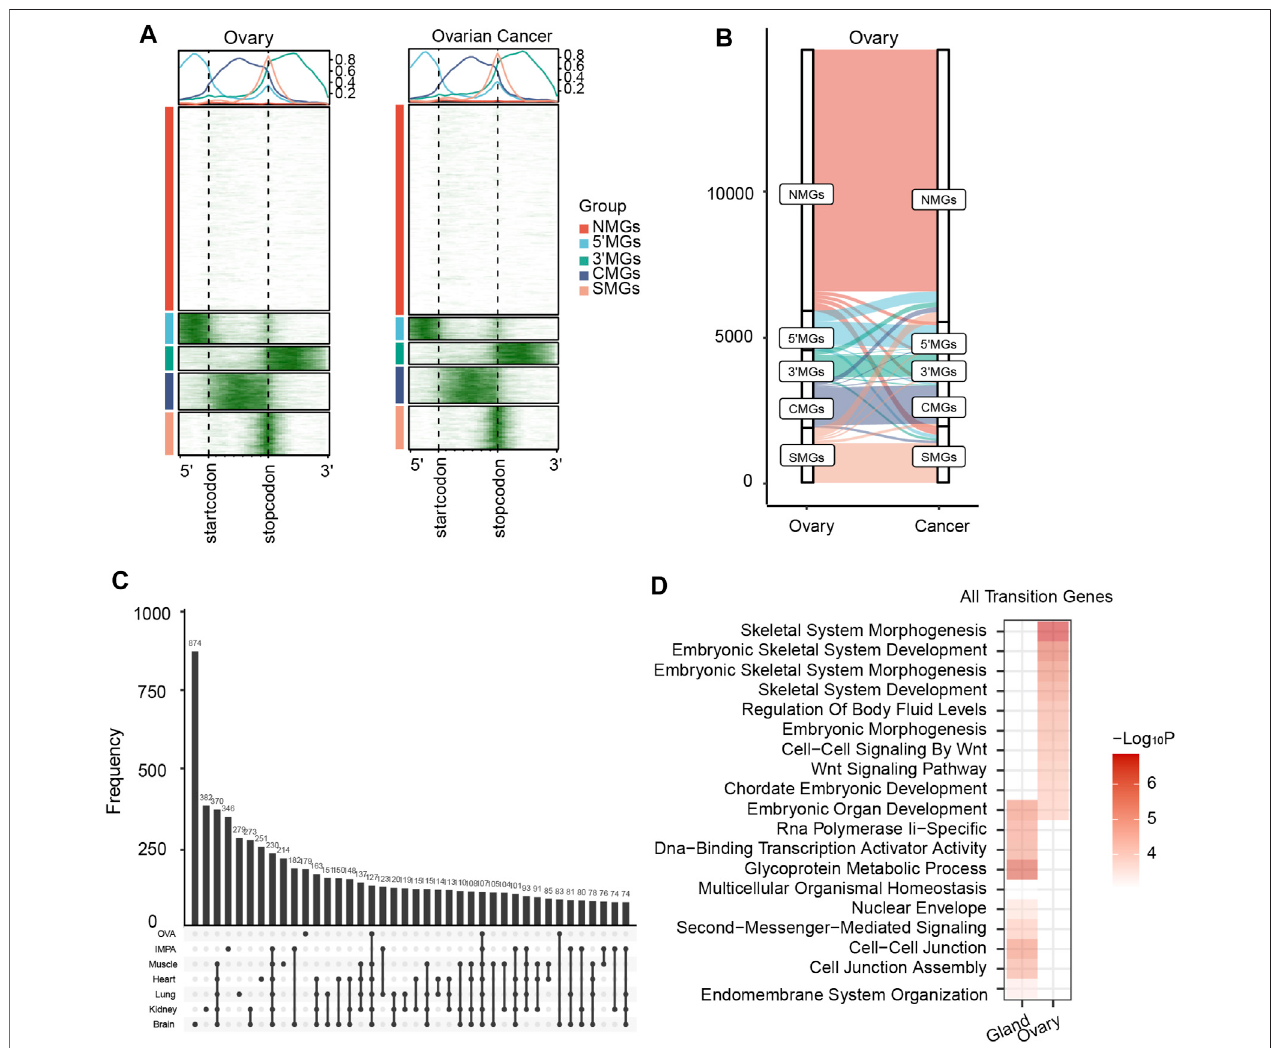
FIGURE 5 | m6A transition between normal and cancer which related to embryonic development. (A) The m6A topological patterns along the m6A deposited regions in human ovary and ovarian cancer. White color means without m6A peak, green color means with m6A peak. (B) The m6A topological transition between the ovary and ovarian cancer. (C) The overlap of all transited genes among all human tissues, invasive malignant pleomorphic adenoma (IMPA) and ovarian (OVA) cancer samples. (D) Heatmap showing function enrichment analysis of all transited genes between the two normal and cancer samples. Color key from white to red indicates − Log 10P